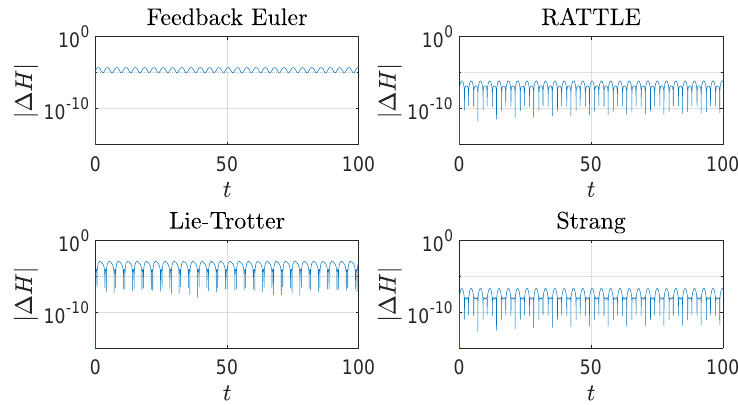
Figure 4. The trajectories of the energy error, | ∆ H ( t ) | = | H ( t ) − H ( 0 ) | , 0 ≤ t ≤ 100, of the spherical pendulum generated by four different methods with step size h = 10 − 3 : a feedback integrator with the Euler scheme, the RATTLE method, the Lie–Trotter splitting method, and the Strang splitting method. A logarithmic scale is used on the y -axis.